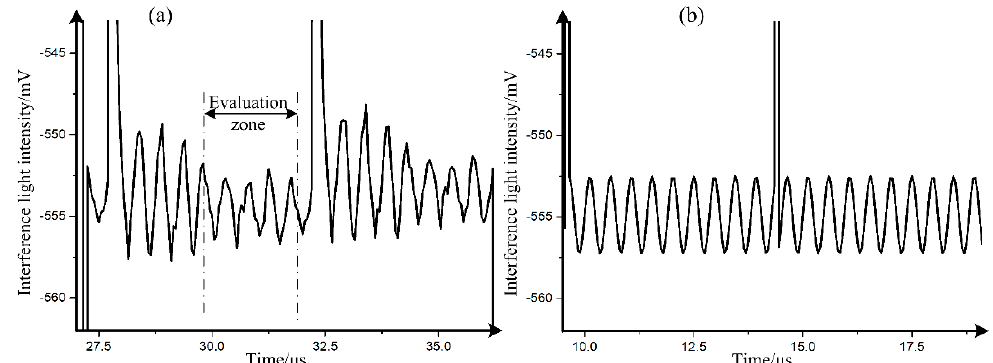
Figure 6. ( a ) Interference light intensity signal obtained by the A/D convertor; ( b ) interference light intensity signal by simulation with the measurement results.